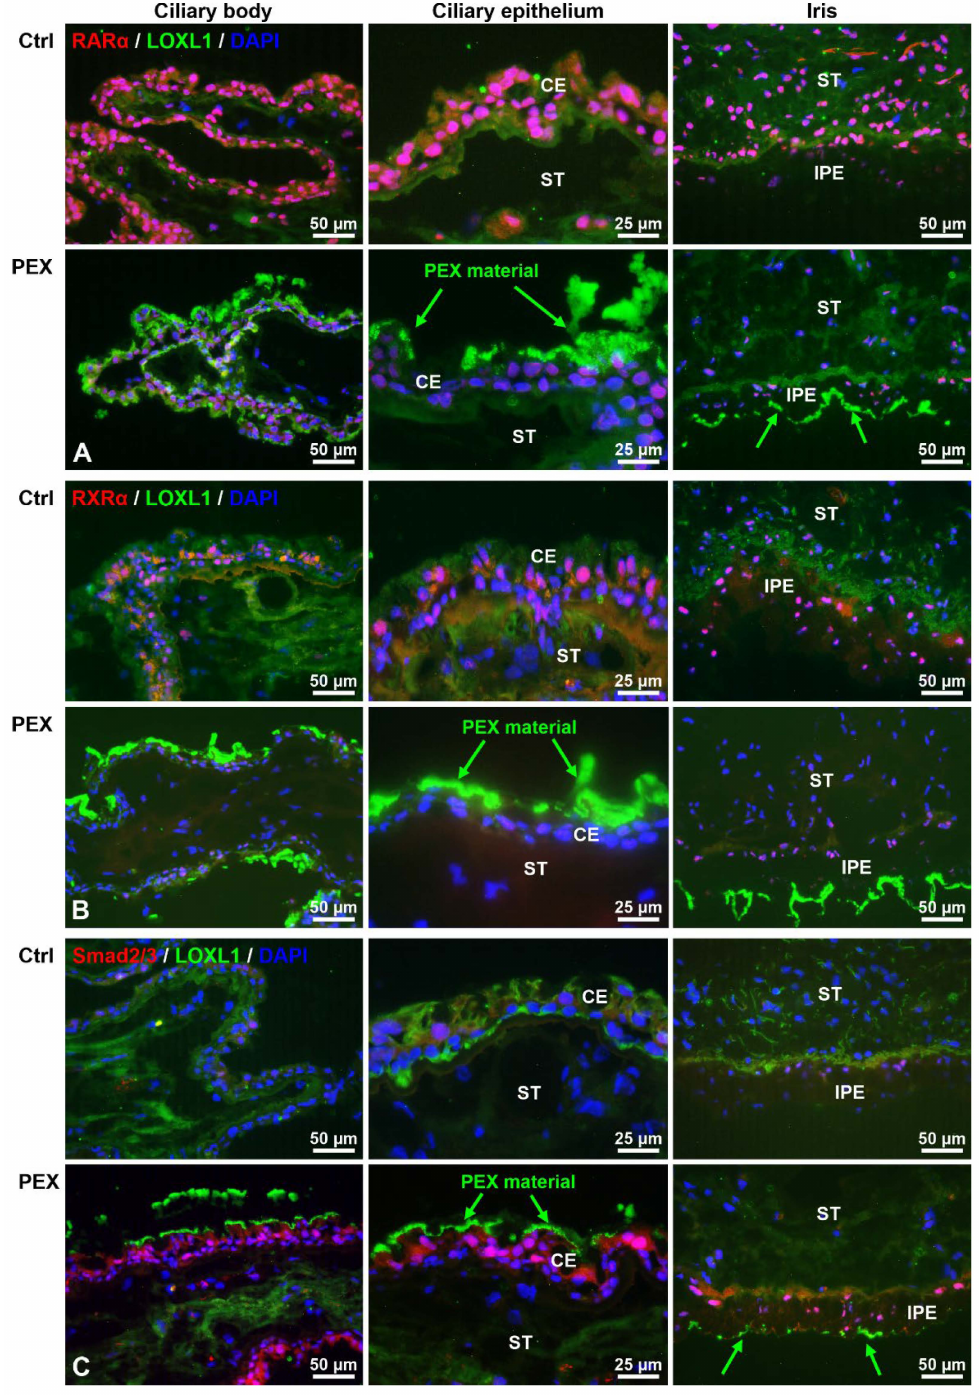
Figure 2. Immunohistochemical localization of RAR α , RXR α , LOXL1, and Smad 2/3 in ocular tissues of normal human control (Ctrl) and PEX eyes. Double labeling of RAR α ( A ), RXR α ( B ), and Smad2/3 ( C ) (red fluorescence) in cell nuclei and LOXL1 (green fluorescence) in PEX material accumulations (arrows) on ocular surfaces; nuclear counterstaining with 4 (cid:48) ,6-diamidino-2-phenylindole (DAPI, blue fluorescence). CE, ciliary epithelium; IPE, iris pigment epithelium; ST,